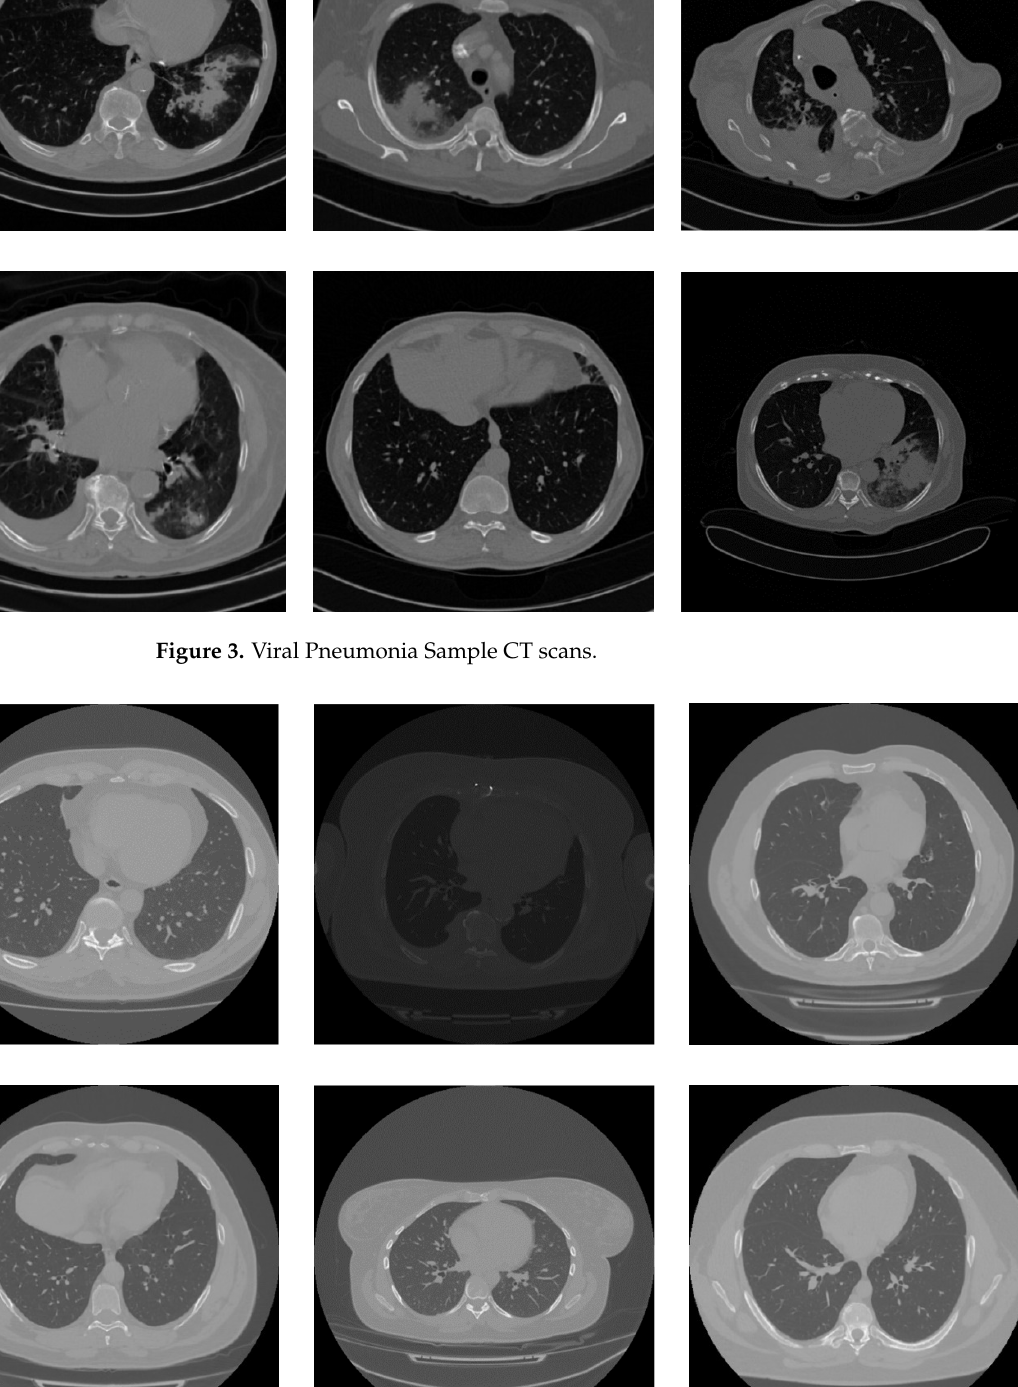
Figure 4. Normal Sample CT